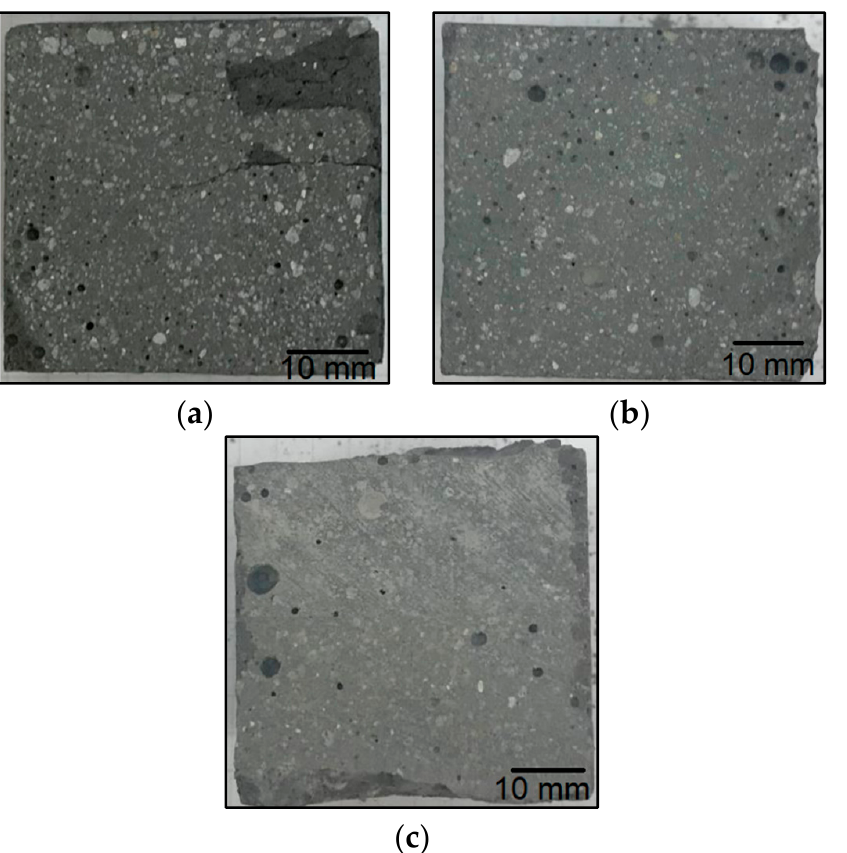
Figure 13. Breakthroughs of geopolymer samples based on fly ash and river sand with the addition of fraction II from a windmill turbine: ( a ) 5% fraction addition; ( b ) 15% fraction addition; ( c ) 30% fraction addition.